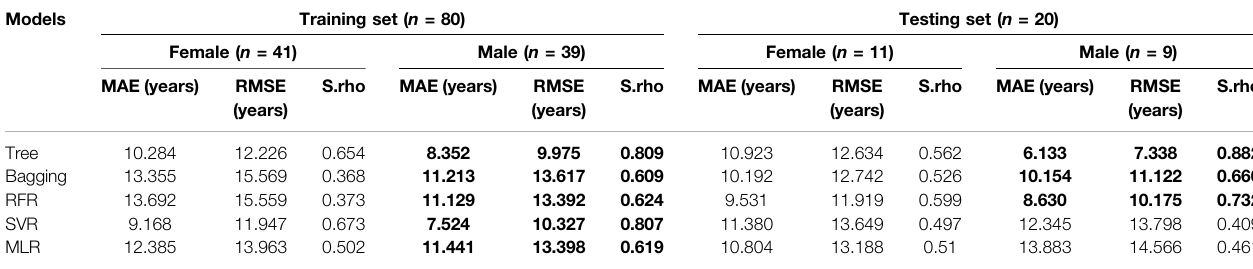
TABLE 3 | Age prediction performance of different models between female and male groups.